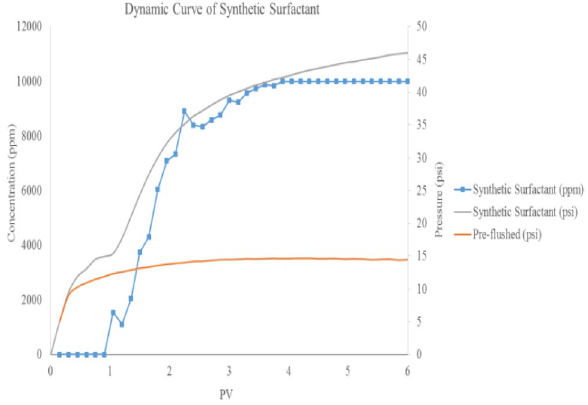
Fig. 5 Dynamic adsorption curve for surfactant